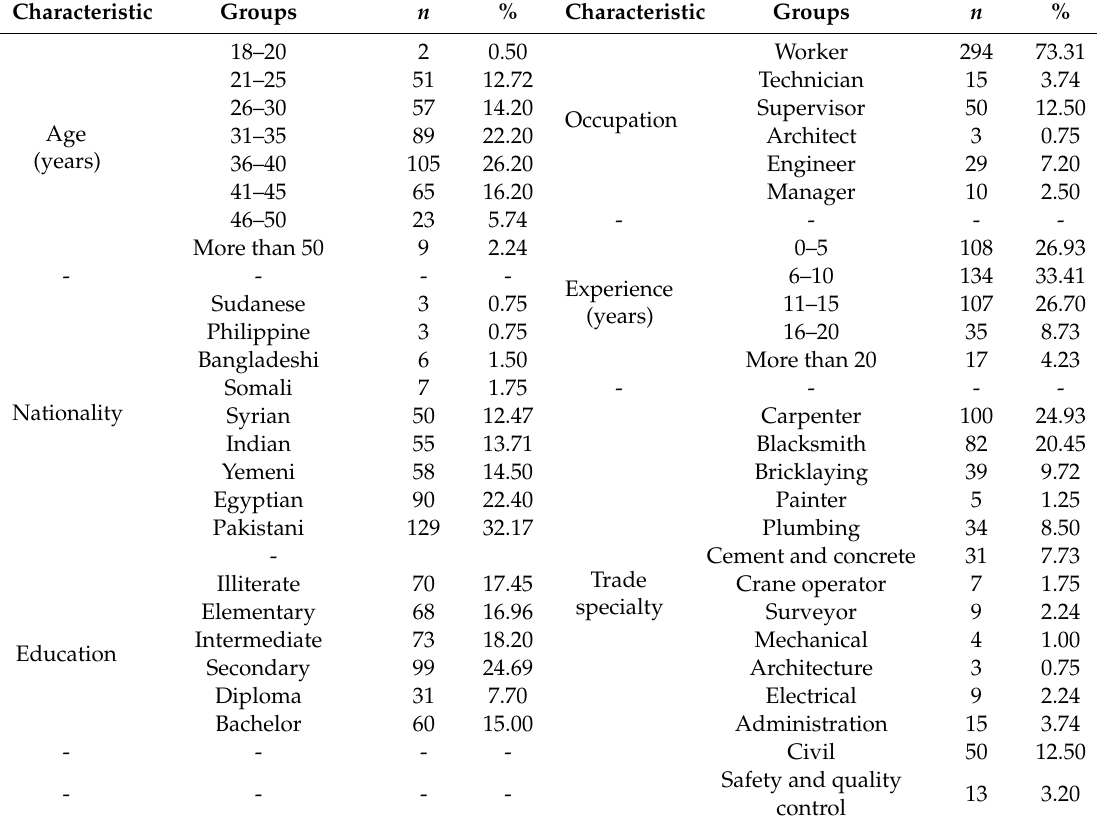
Table 4. Research sample sociodemographic ( n =